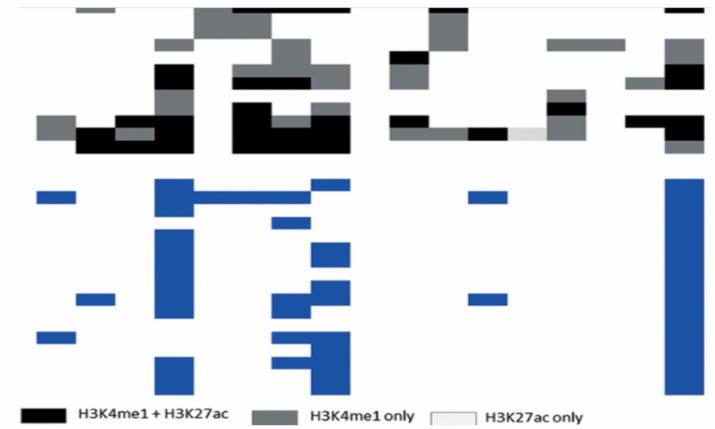
Figure 3. The epigenetic patterns H3K4me3 in a cancer groups CDT, LHC, HEC, and AHC.